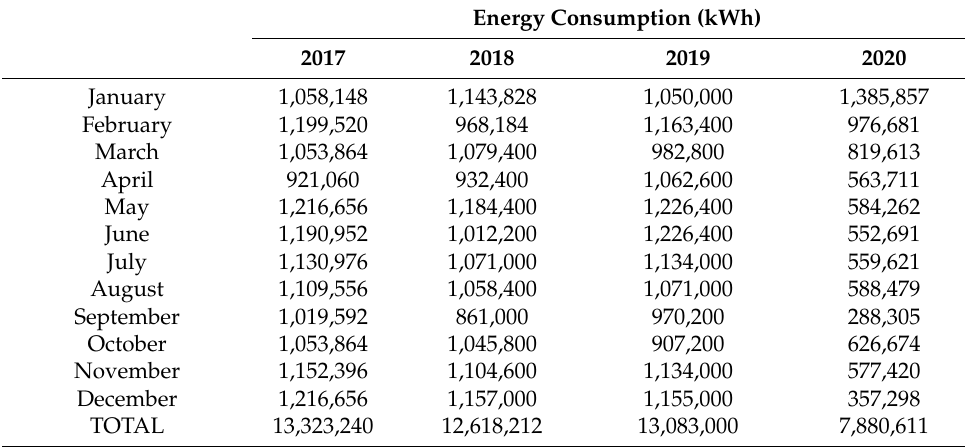
Table 2. Monthly electricity consumption of ESPOL campus from 2017 to